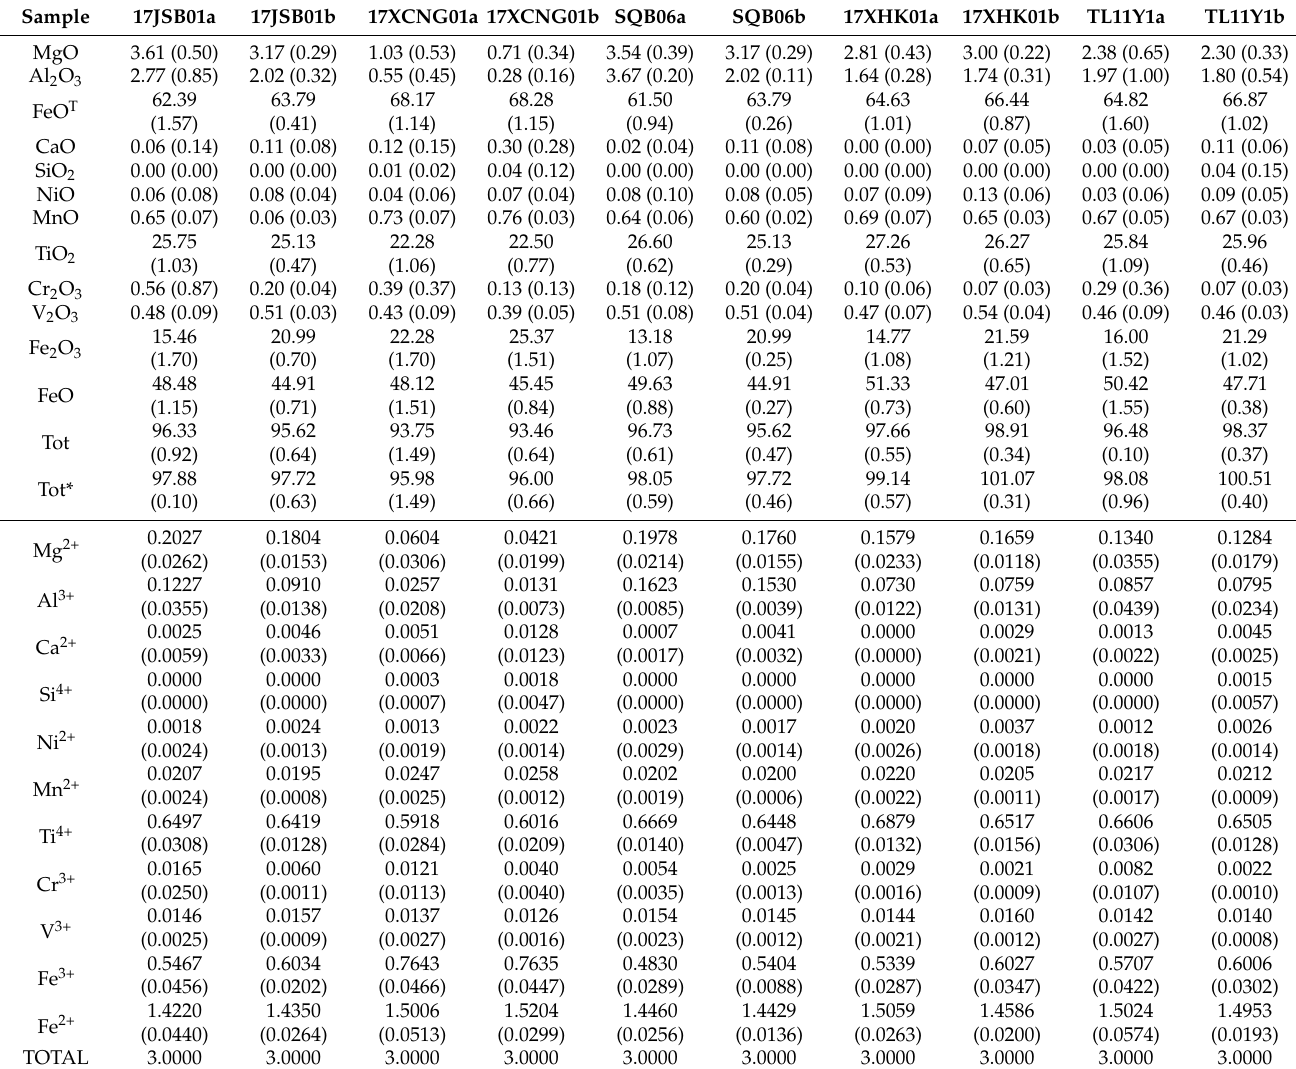
Table 4. Major elements in titanomagnetite from the Hannuoba alkaline basalt (wt%) and the number of cations based on four oxygen